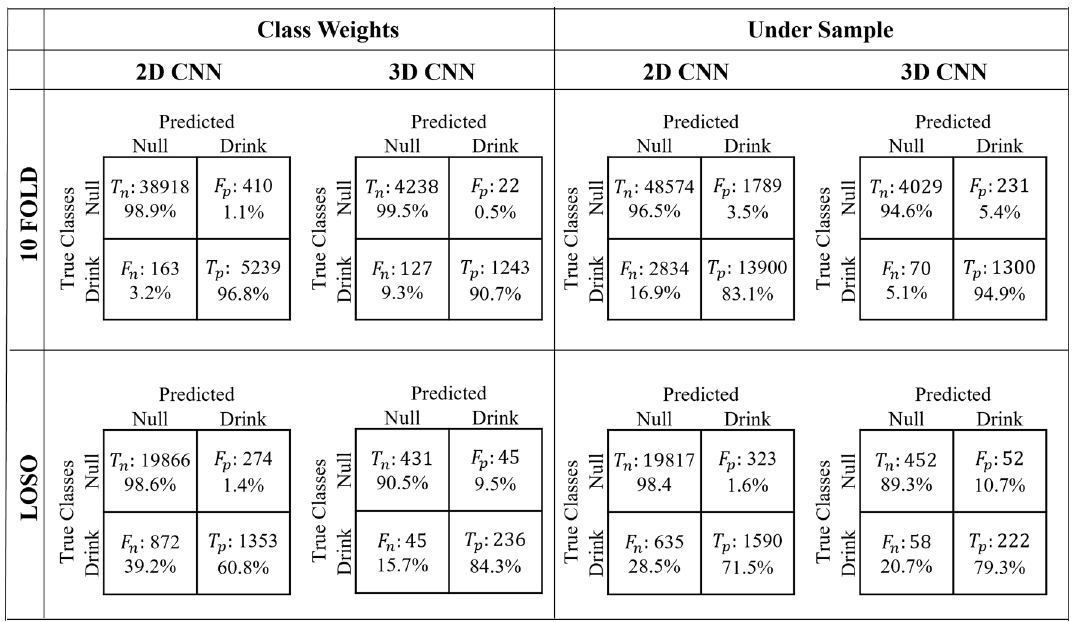
Figure 4. Distribution of F1 score for all models trained with various parameters.